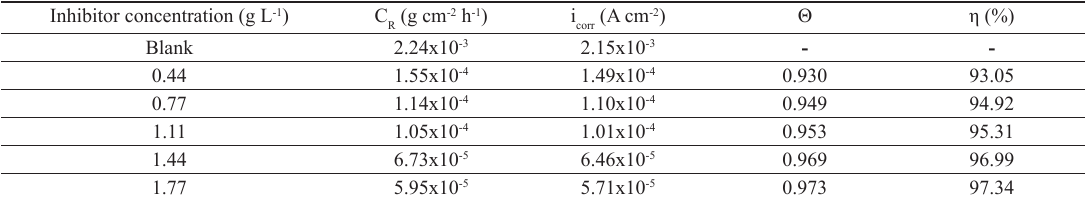
Table 6. Results from gravimetric tests in 0.5 mol L -1 HCl solution. Inhibitor concentration (g L -1 )